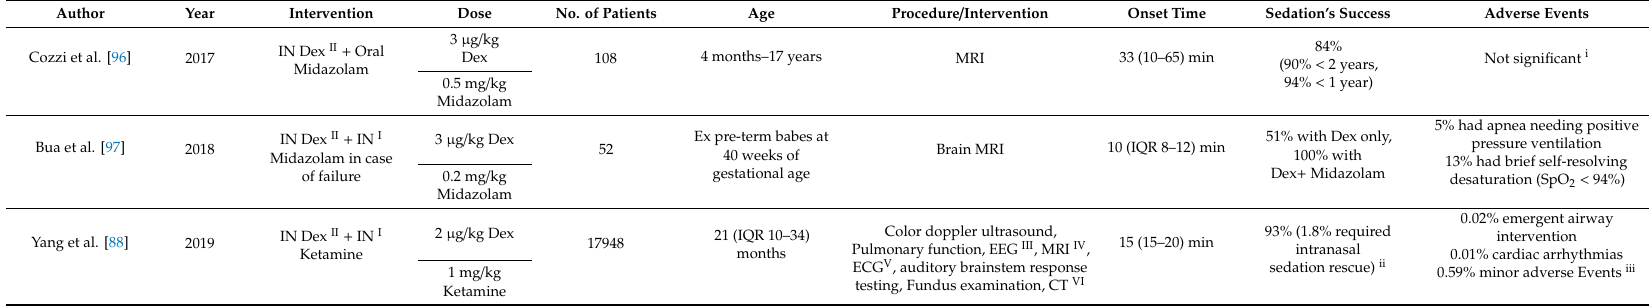
Table 3. Characteristics of the studies evaluating intranasal dexmedetomidine in association with available sedative